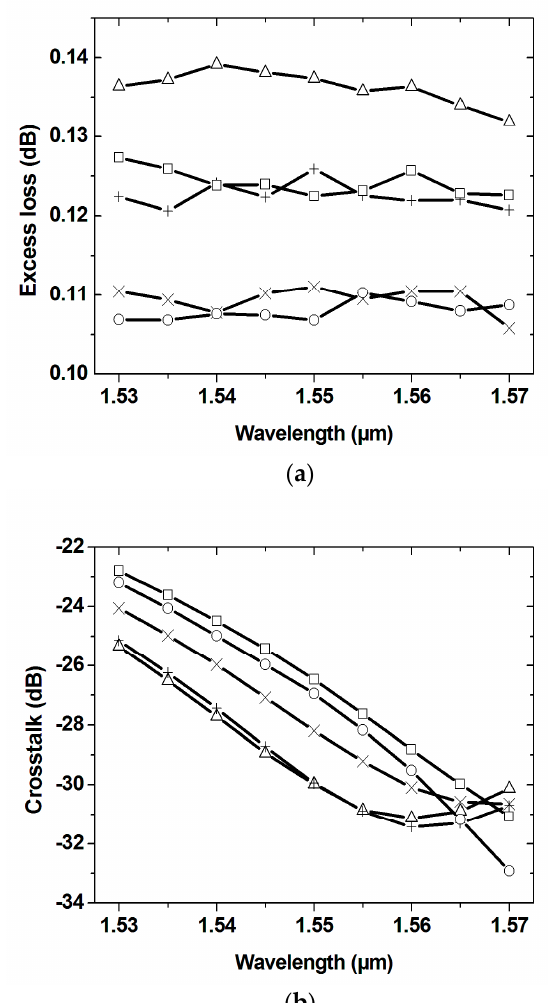
Figure 5. Variations of ( a ) excess loss and ( b ) crosstalk with wavelengths between 1530 and 1570 nm. The symbols of splitting ratio: △ 50:50; + 60:40; × 70:30; □ 80:20; ○ 90:10.